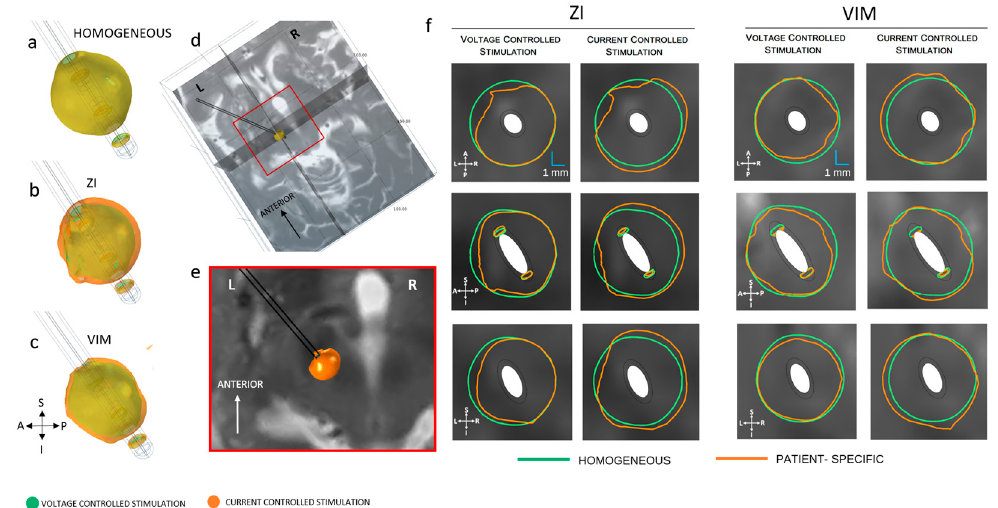
Table 1. Homogeneous and patient-specific electric field (EF) volumes (<0.2 V/mm isosurface) achieved with different operating modes and the relative difference between each target and the homogeneous volumes.